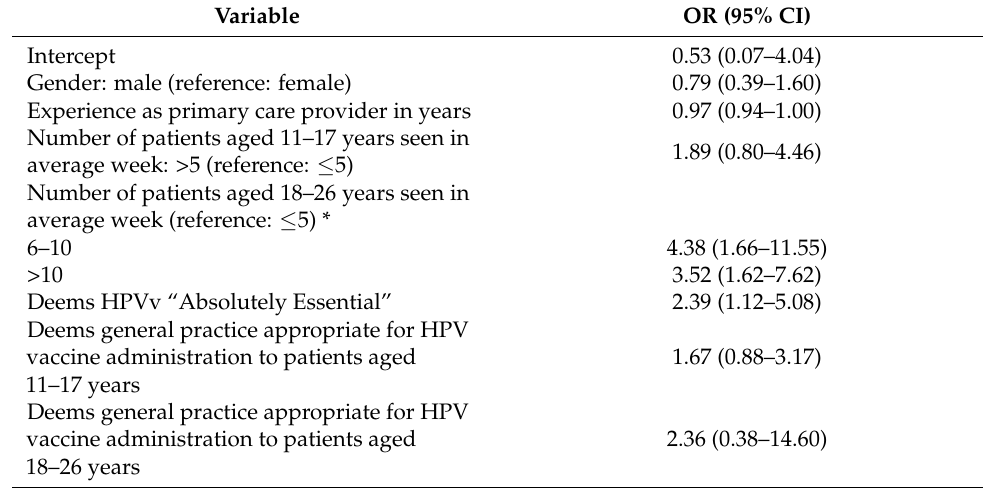
Table 4. The multivariable logistic regression on human papillomavirus (HPV) vaccination offering for general practitioners (offers versus does not offer, n = 304). Abbreviations: confidence interval (CI); odds ratio